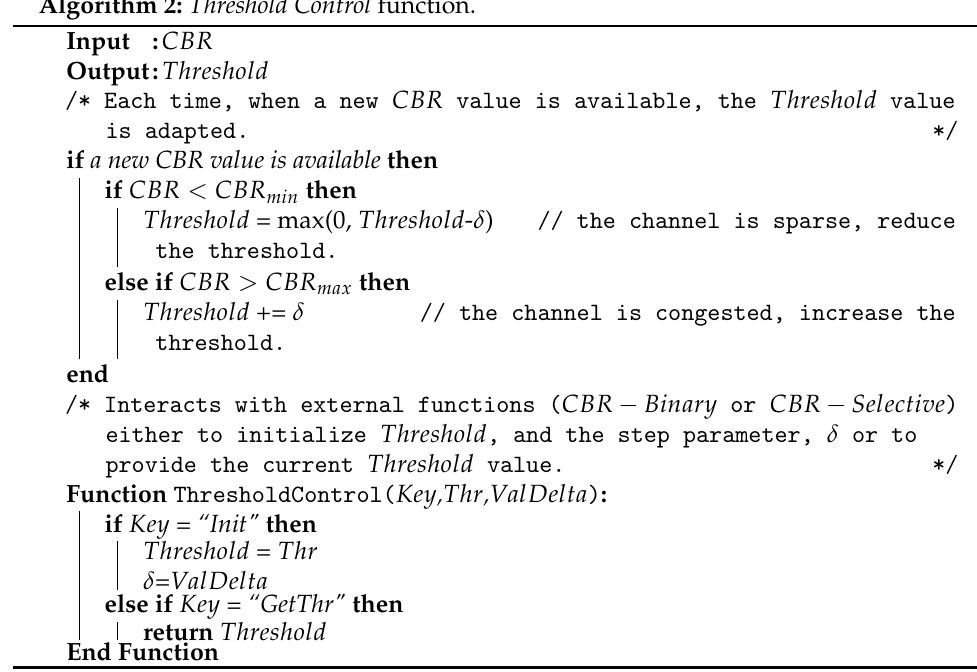
Algorithm 2, the threshold control algorithm increments Threshold by δ , if the current CBR